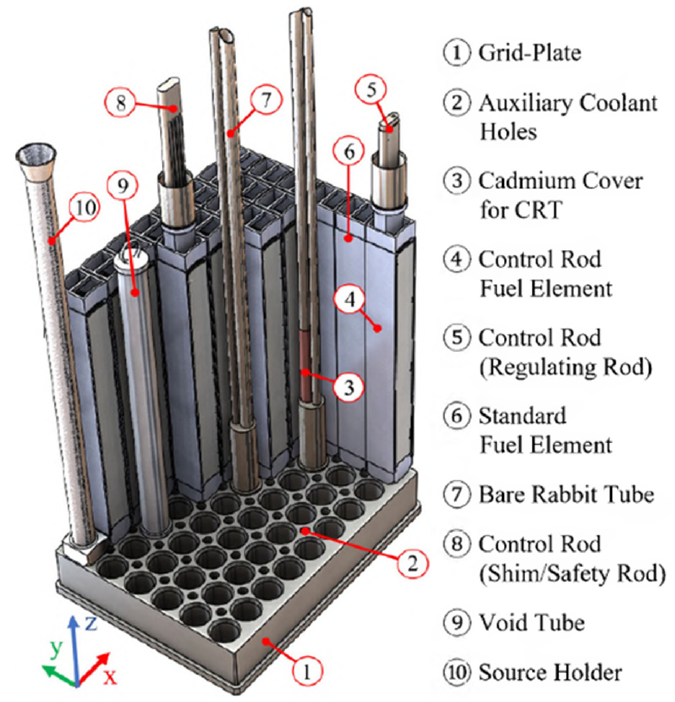
Figure 1. The MSTR core elements. Figure is taken from [13].